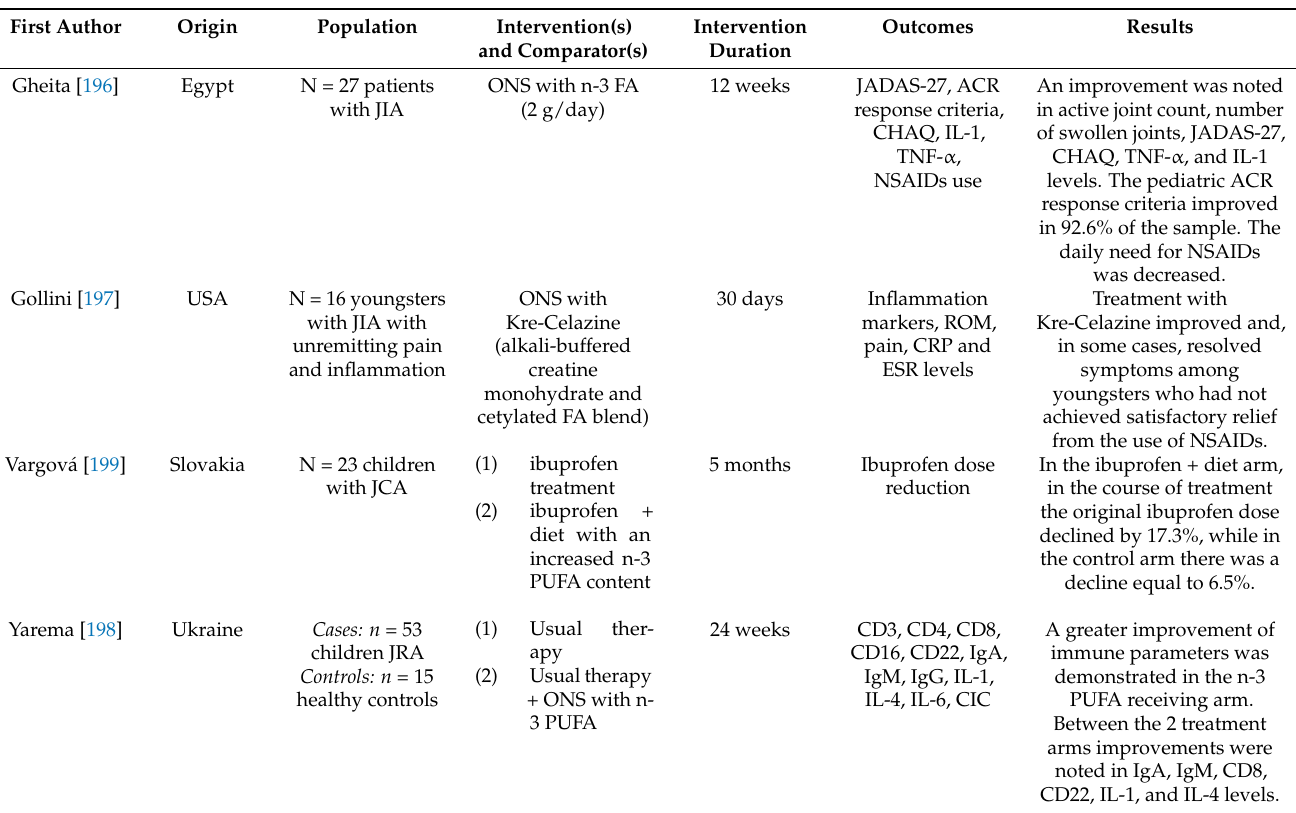
Table 6. Clinical trials delivering dietary interventions for improving bone health in children with